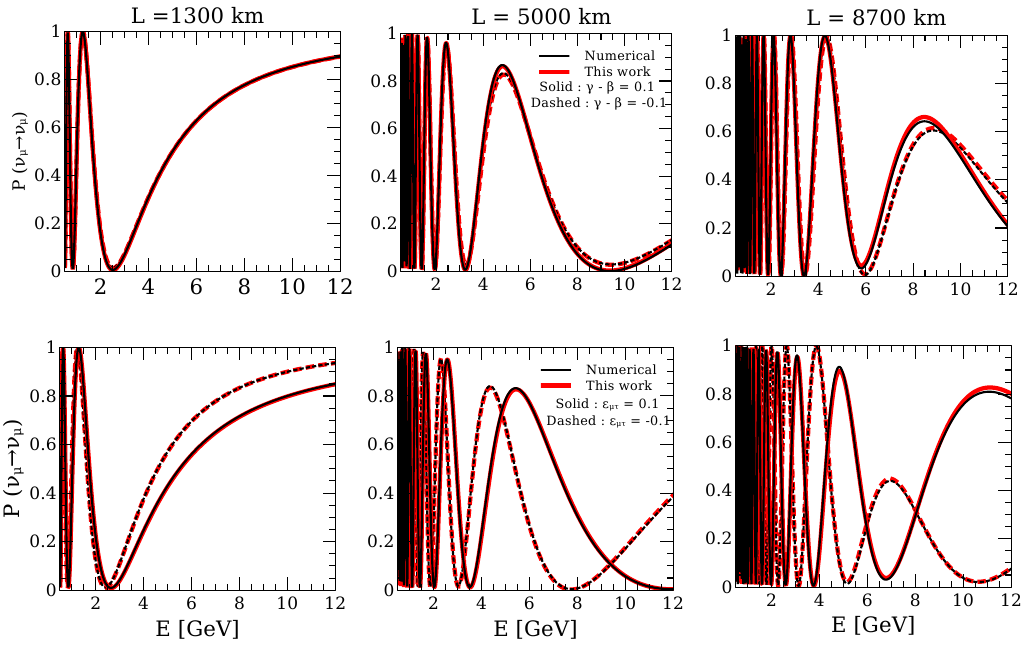
-0.1Solid : ɛ μτ = Dashed : ɛ μτ =